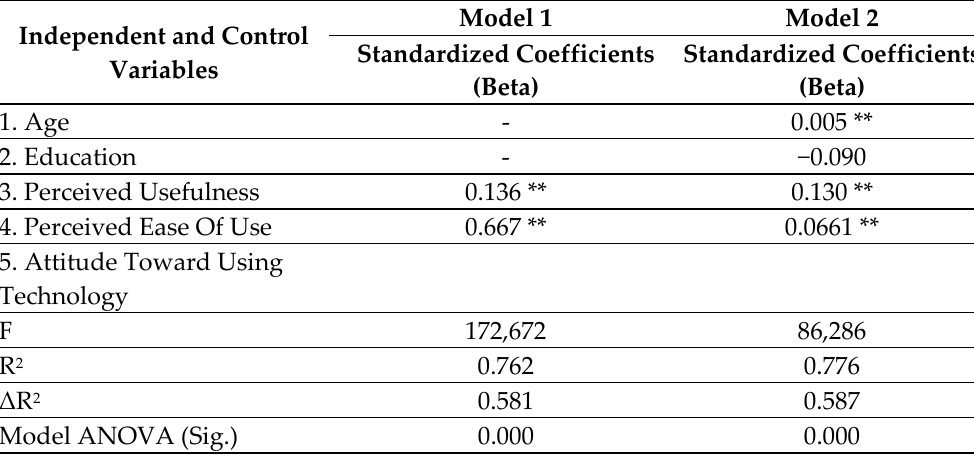
Table 6. Regression